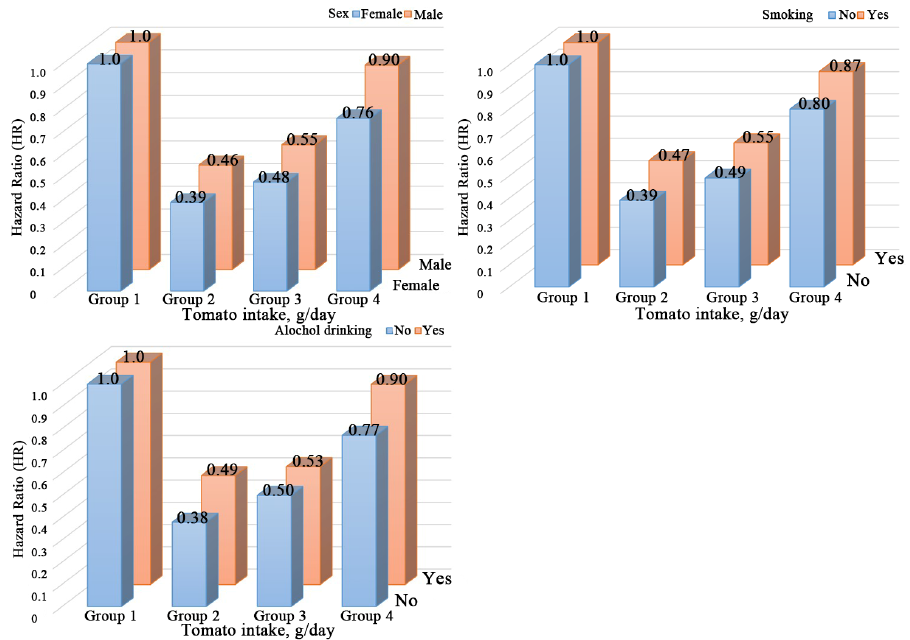
Figure 3. Joint analysis of dietary tomato intake and population characteristics (sex, smoking, and alcohol drinking status) in relation to new-onset hypertension. A: sex; B: smoking; and C: